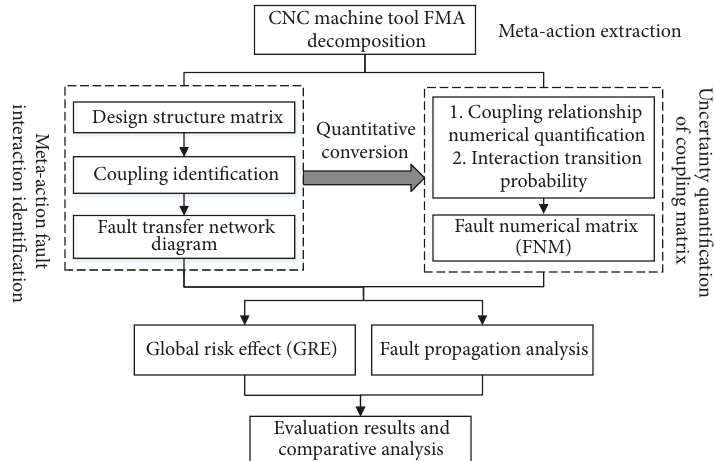
Figure 3: Flow chart of coupled fault propagation analysis of